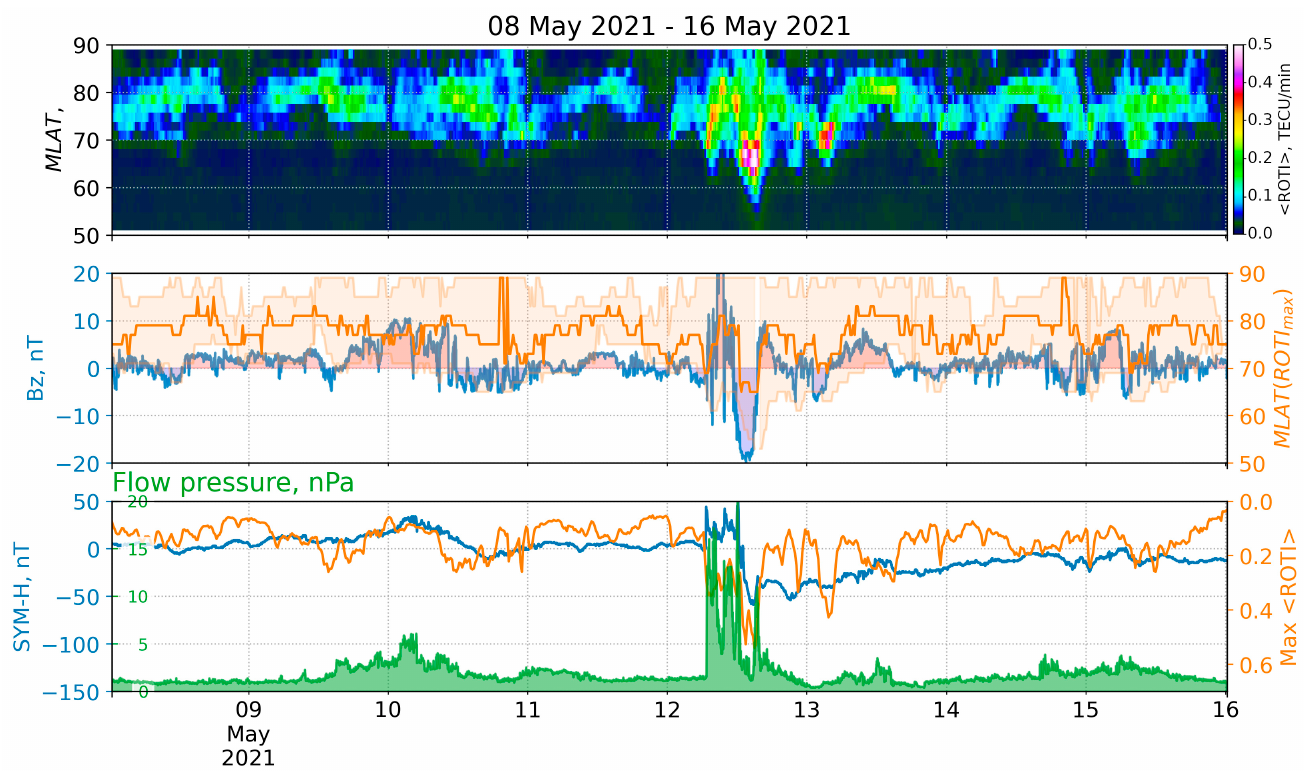
Figure 4. ROTI keogram and space weather parameters for the storm of 12 May 2021: ( top ) keogram of average ROTI (<ROTI> versus MLAT versus time); ( middle ) IMF Bz ( blue ), MLAT positions of maximum <ROTI> ( orange ), and values exceeding median ROTI at the moment ( orange filling ); ( bottom ) SYM-H index ( blue ), <ROTI> max ( orange ), and flow pressure ( green ). The top panel in Figure 4 shows average ROTI (<ROTI>) versus magnetic latitude (MLAT) and time – ROTI keogram. The middle panel shows variations in IMF Bz (blue) and the magnetic latitude of the maximal <ROTI> at the moment (orange, Y -axis at right). The area filled by pale orange (Figure 4, middle) reflects magnetic latitudes of all the <ROTI> values exceeding the entire map median ( Y -axis at right). The bottom panel shows solar wind flow pressure (green), SYM-H (blue) and the maximal <ROTI> value (orange, Y -axis at